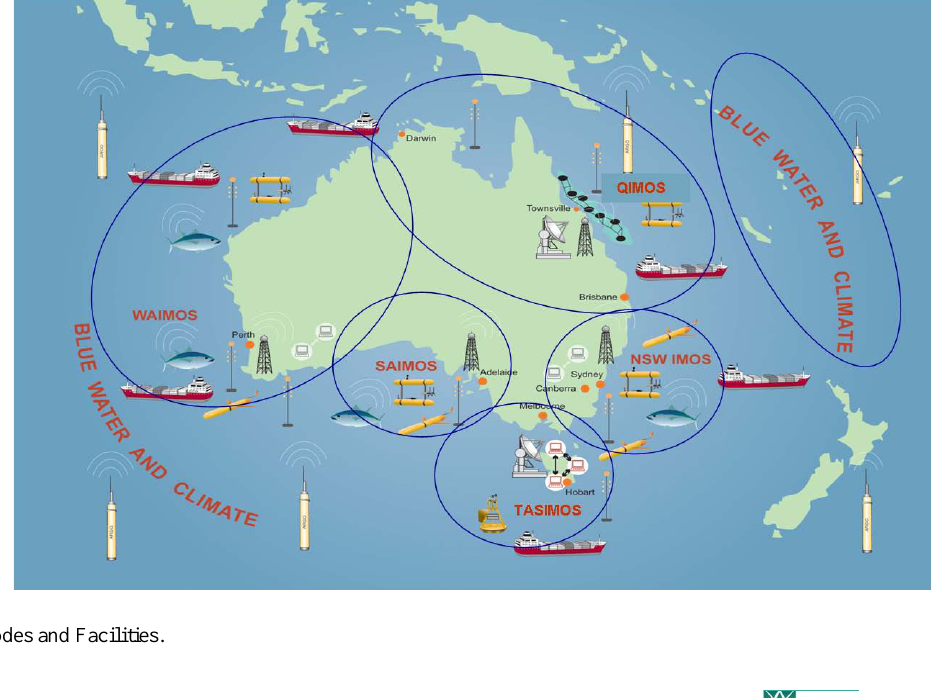
Fig. 2. IMOS Nodes and Facilities.